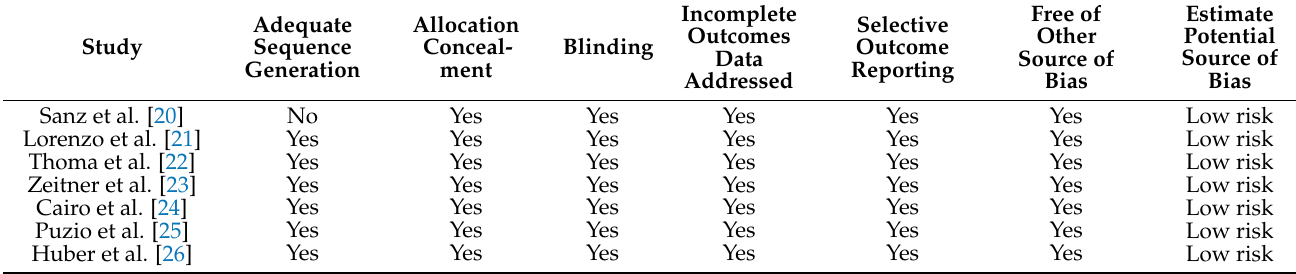
Table 3. Assessments of the risk of